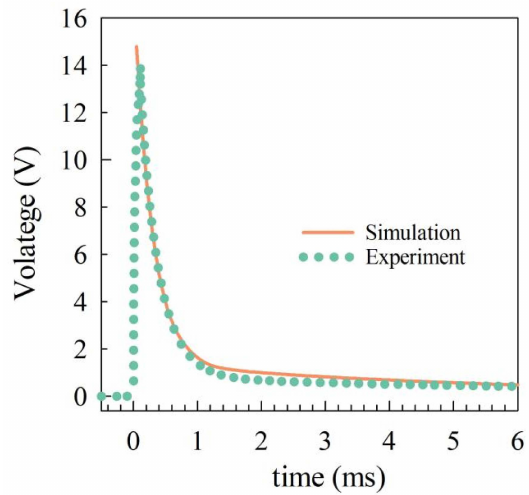
Figure 4. The coil voltages from experiment and simulation in the discharging tests with a 2 mm copper disc. Rd is 0.51 Ω , Initial current is 29.0